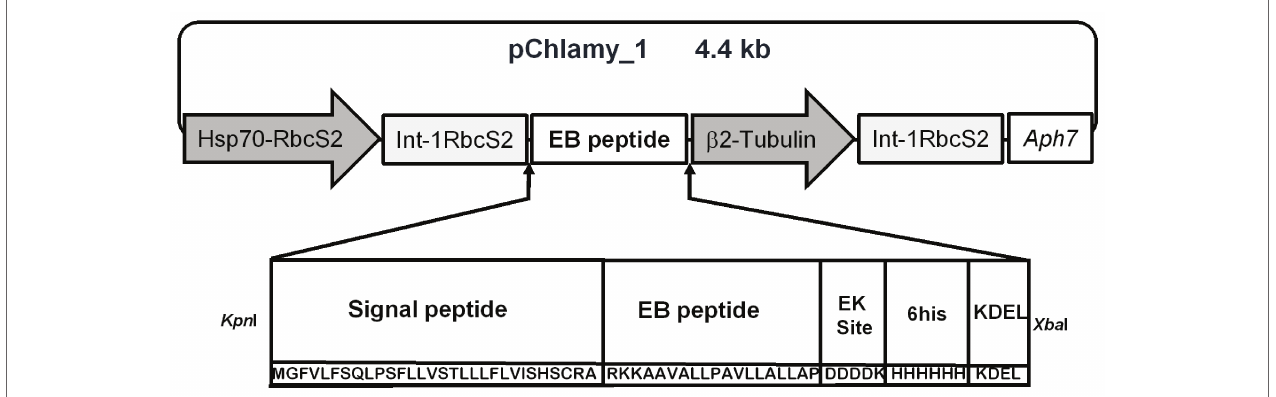
FIGURE 1 | Components of the transformation vector for EB expression in Chlamydomonas reinhardtii . EB gene sequence optimized for expression in Chlamydomonas reinhardtii cloned between KpnI and XbaI restriction sites into pChlamy_1 vector. The EB peptide amino acid sequence has additional components: Signal peptide: Pr1a sequence; EK site: Enterokinase protease site; 6his: six-histidine tag; KDEL: reticulum endoplasmic retention tag. The pChlamy vector has the following elements: Hsp70A-RbcS2 promoter, Int-RbcS2 is RuBisCO Small Subunit 2 intron, B2 tubulin promoter, and Aph 7 gene from hygromycin